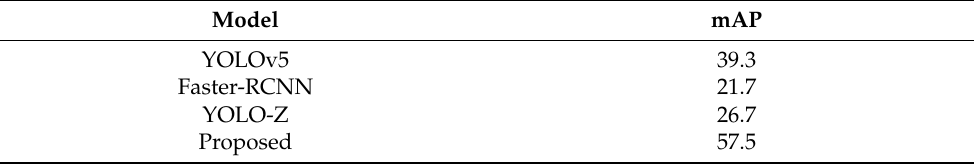
Table 4. Benchmarks on vehicle detection task.